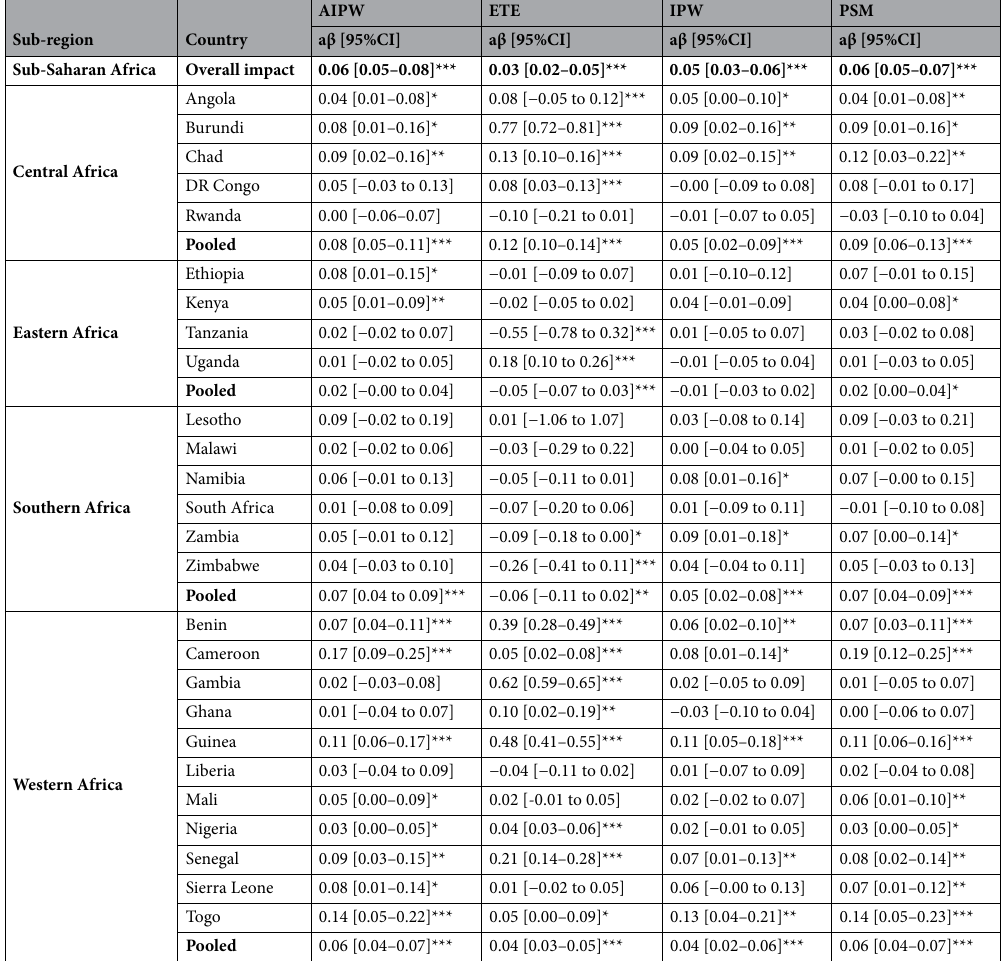
Table 3. Impact of exposure to family planning information messages on contraceptive use among adolescents aged 15–19 years in Sub-Saharan Countries, evidence from DHS study. Analysis adjusted for; the age of household head, sex of household head, wealth index, place of residence, religion, respondent age, marital status, educational level, currently working, and the number of children ever born. DHS Demographic Health Survey, AIPW augmented inverse probability weighting, ETE endogenous treatment effects, IPW inverse probability weighting, NNMatch nearest neighborhood matching (1:1), PSMatch propensity score matching (1:1), aβ adjusted coefficient estimate, CI confidence interval. P-value notation: *p-value < 0.05, **p-value < 0.01, ***p-value < 0.001. Values in bold highlight the estimates at the regional block